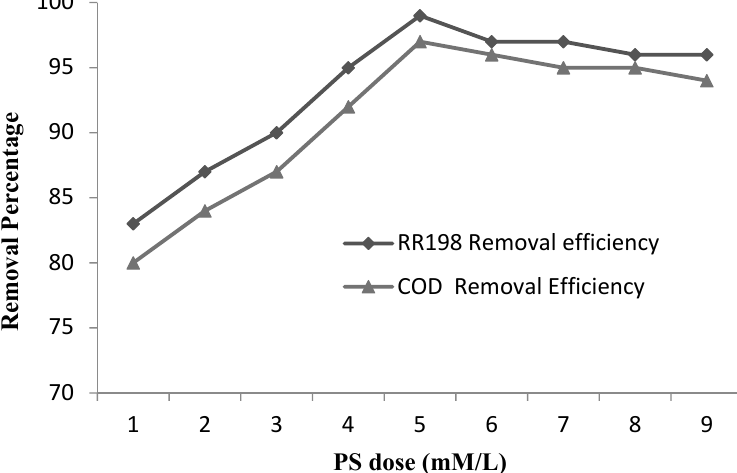
Figure 7. Effect of PS dose on RR198 and COD removal efficiencies, optimum conditions: [RR198 = 25 mg/L, catalyst dosage = 0.3 g/L, reaction time: 25 min and pH = 6.5].